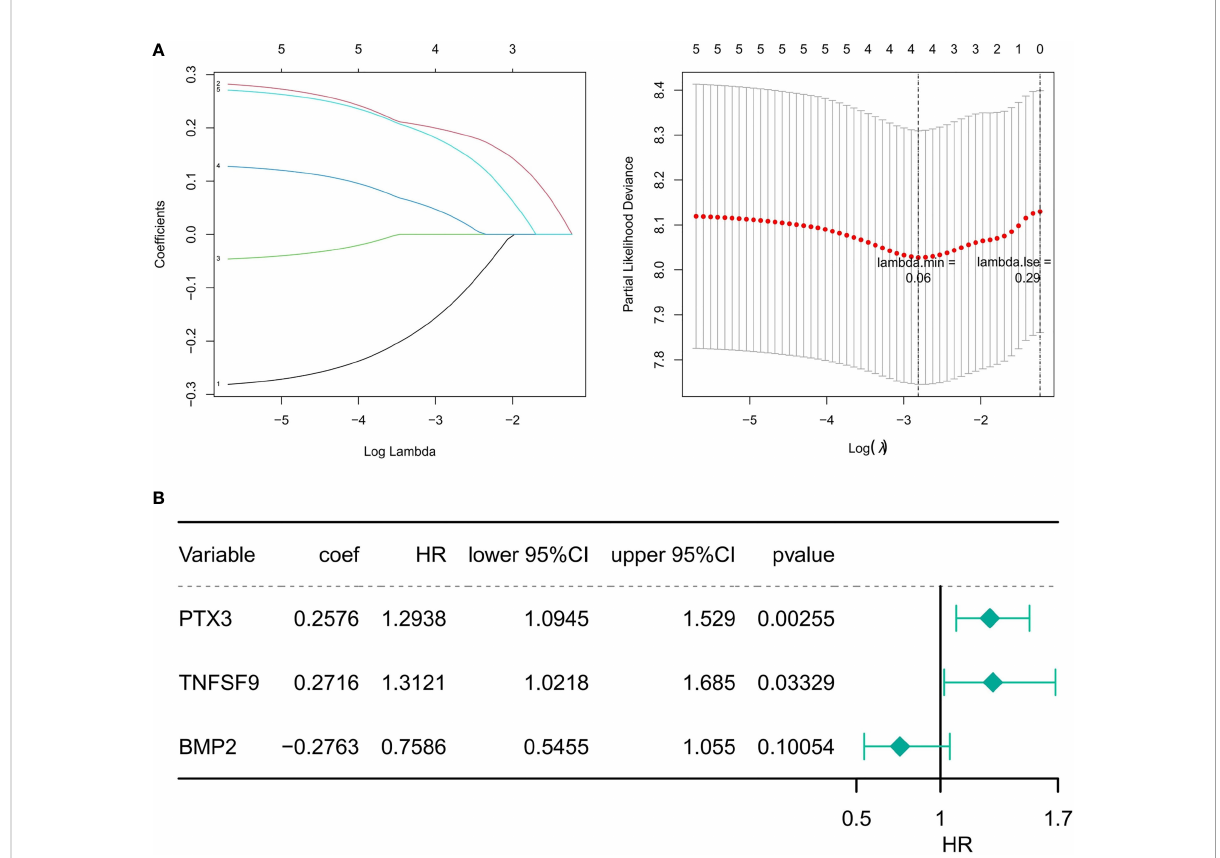
FIGURE 4 Identi fi cation of prognostic DE-IRGs. (A) The diagram of gene coef fi cient and the error diagram of cross validation in LASSO Cox regression. (B) Forest plot of the risk model constructed by the multivariate Cox regression analysis. HR is the hazard ratio, and lower/upper 95% CI is the 95% con fi dence interval of the risk